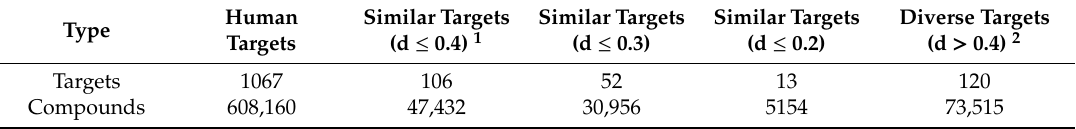
Table 2. Data composition of various target sets divided by taxonomy and target clustering.